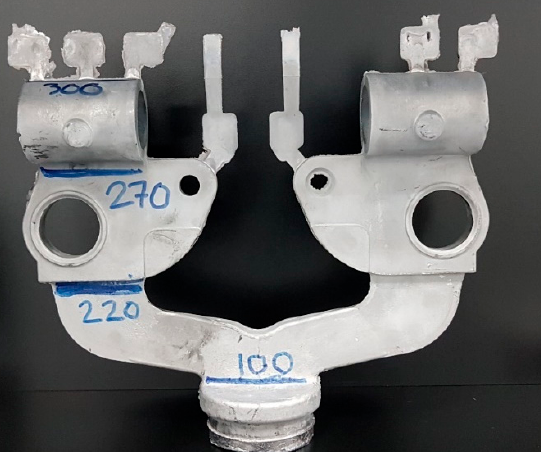
Figure 1. The component cast and the metal levels for the switch points during filling with the numbers indication the piston distance travelled for the melt to reach that level in the die cavity.